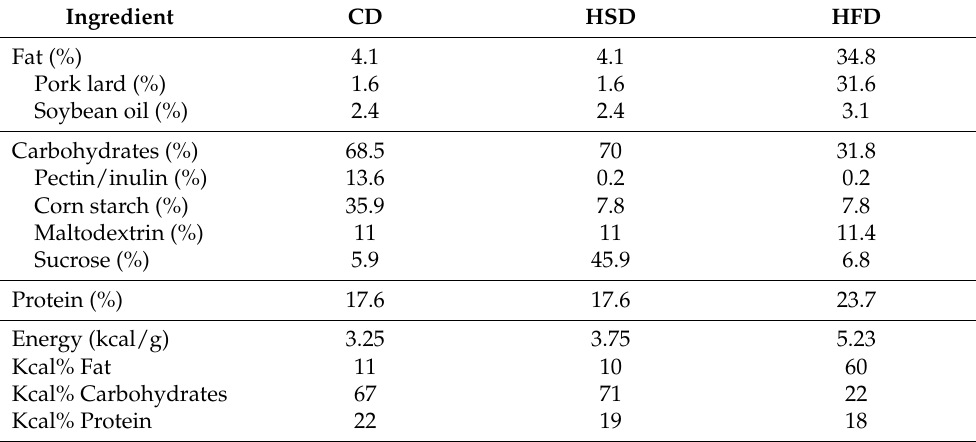
Table 1. Composition of experimental